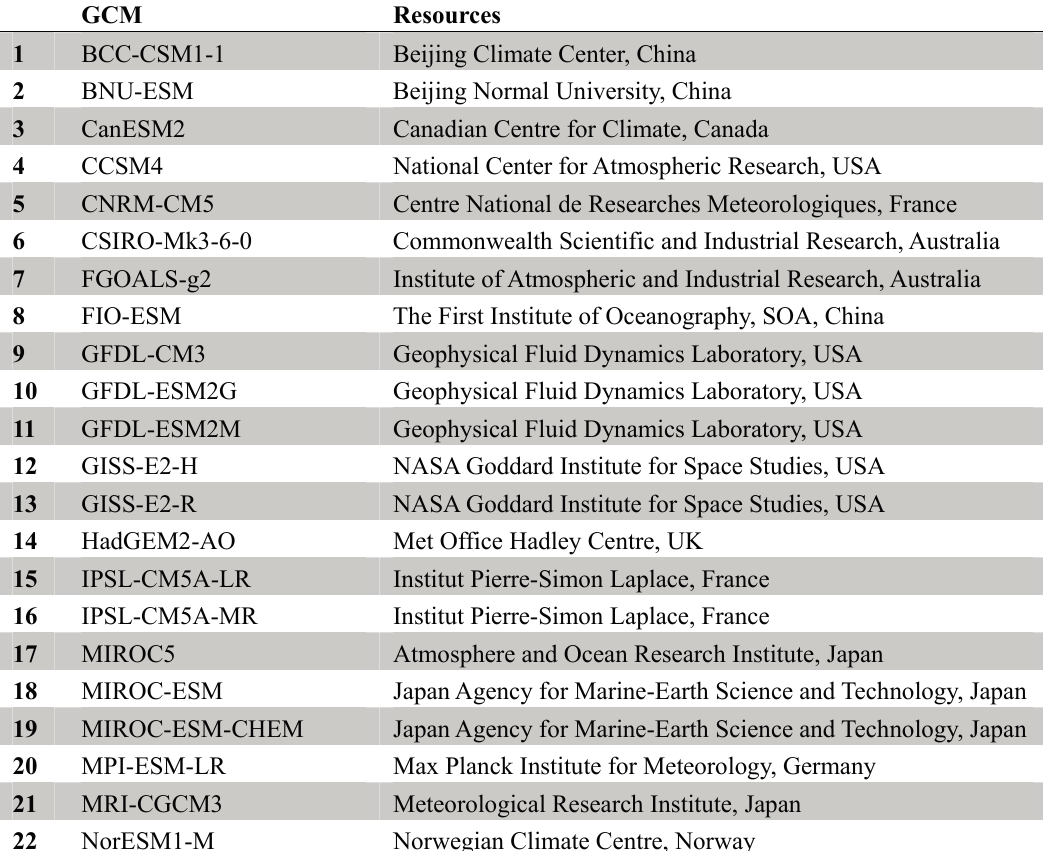
Figure 1. Average vegetation NDVI ( a ); mean temperature ( b ); and total precipitation ( c ) over the growing season from 1982 to 2011. Table 1. List of 22 CMIP5 climate models with a historical run and three future scenarios with their